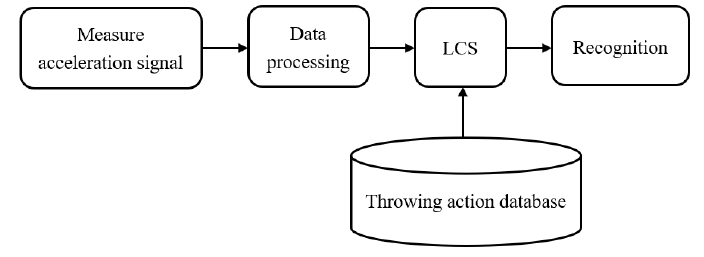
Figure 10. Action identification process. Table 3. Erroneous action definition for different stages of throwing action.